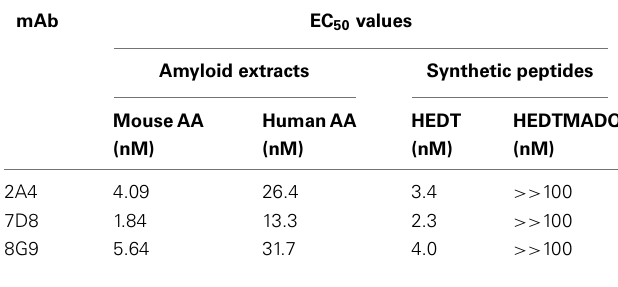
Table 1 | Binding of mAbs toAA amyloid extracts and syntheticAA peptides.